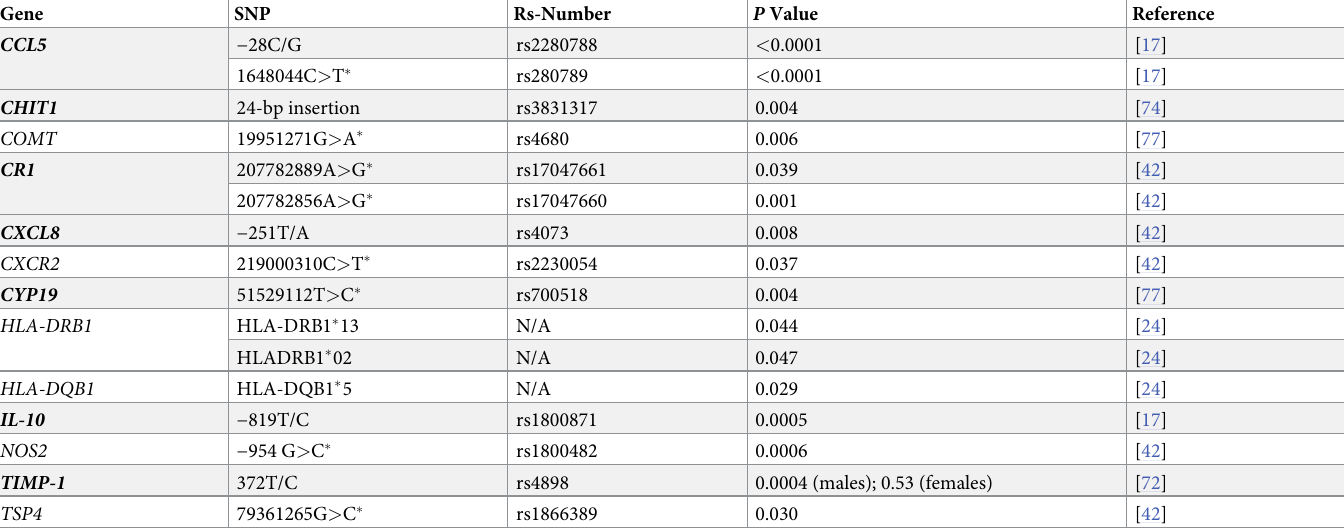
Table 1. A summary of genes with allelic variants that are significantly associated with